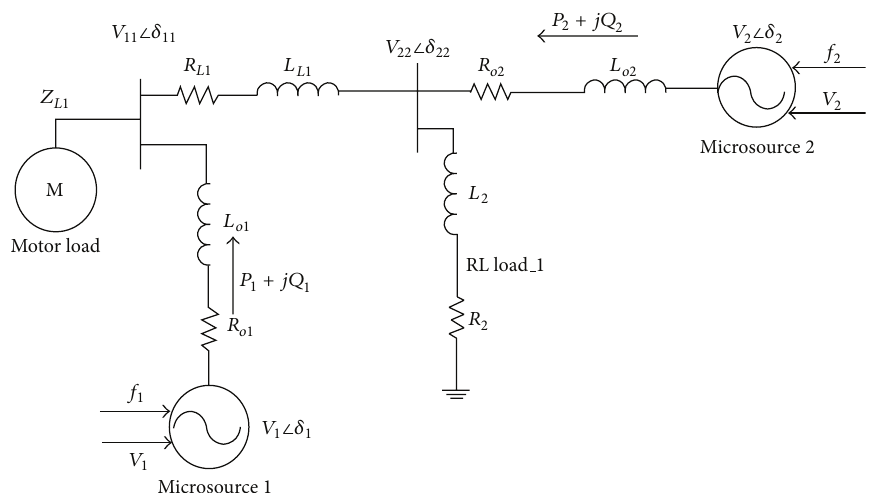
Figure 5: Equivalent model of the microgrid systems.